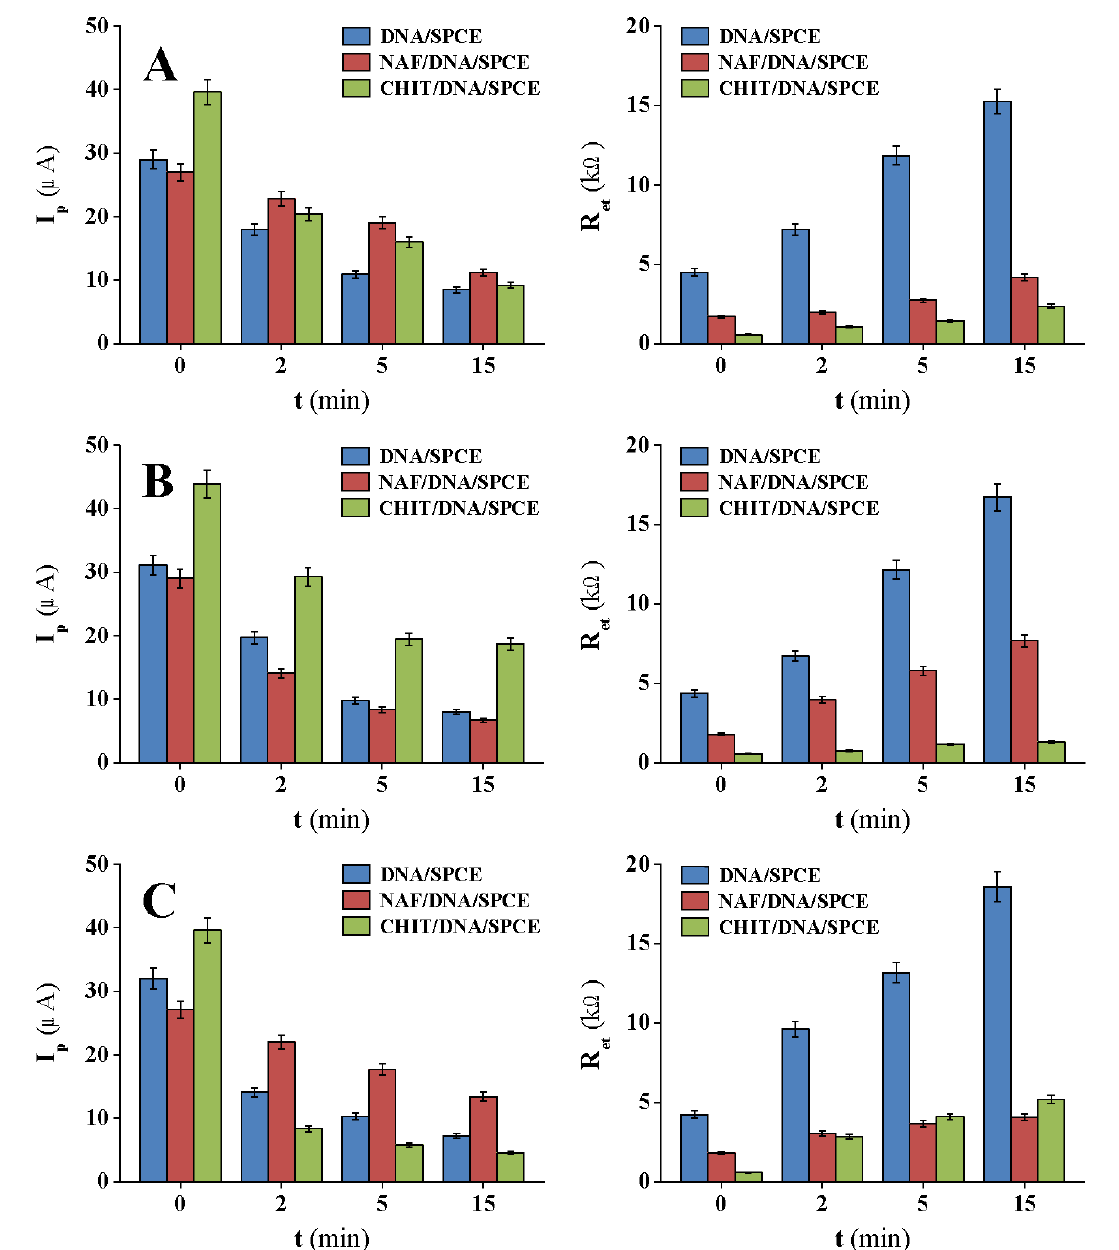
Figure 2. Comparison of the DNA/SPCE, NAF/DNA/SPCE, and CHIT/DNA/SPCE biosensor responses after the treatment in (A) beer, (B) coffee and (C) black tee extracts for a given incubation